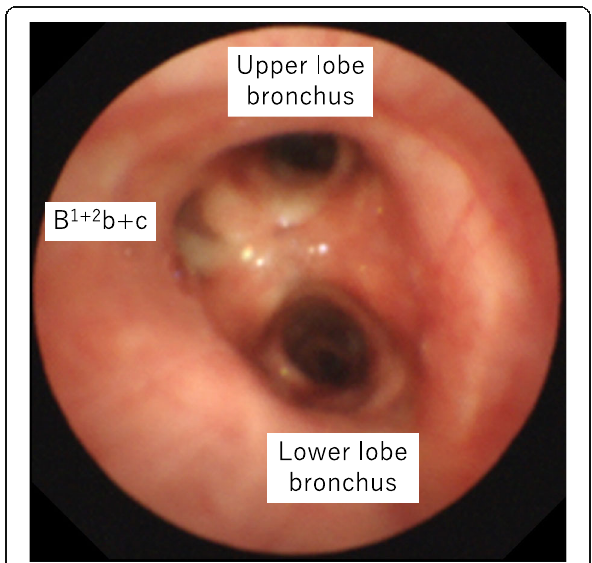
Fig. 2 Bronchoscopic imaging. There are three bronchi branched from the left main bronchus, a branch of the lower lobe and two branches of the upper